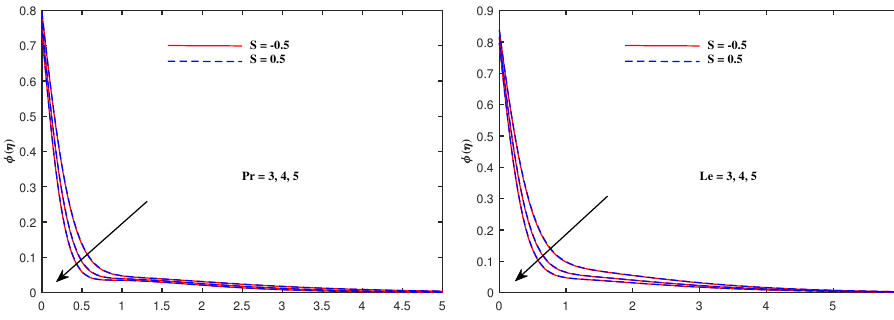
Figure 10. Concentration variation with Pr and Le